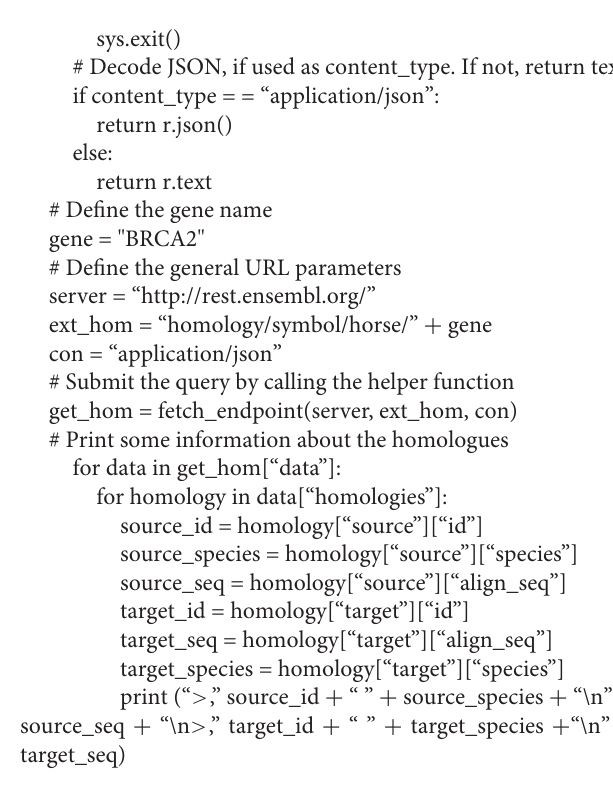
FIGURE 8 | The Ensembl Variant Effect Predictor results page. The summary information at the top shows the consequence information for the uploaded variants. The results table at the bottom shows more detailed information for each uploaded variant including overlapping genes and transcripts.